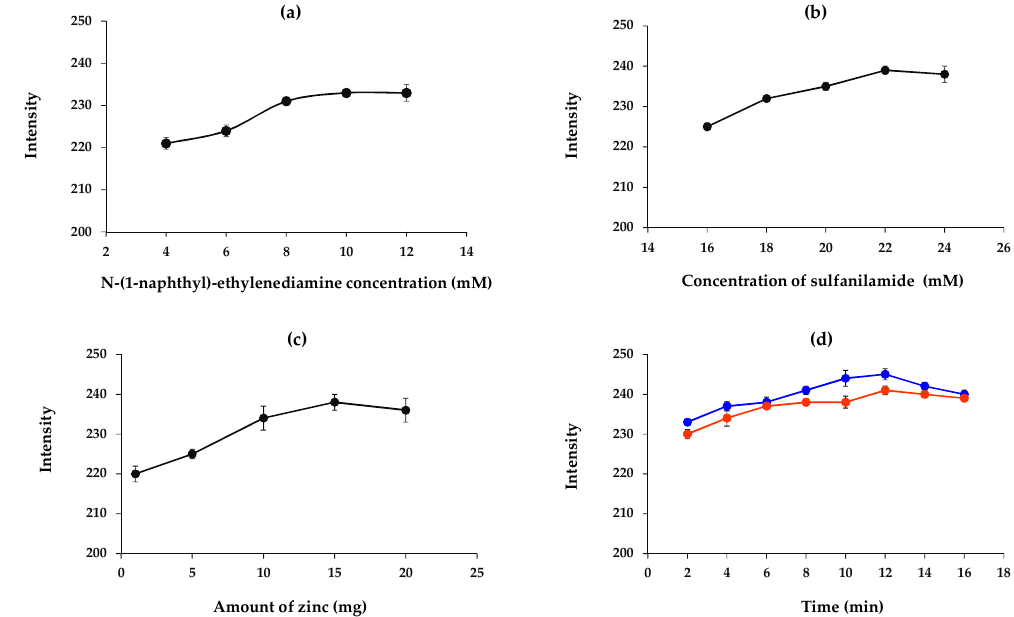
Figure 6. E ff ects of ( a ) N-(1-naphthyl)-ethylenediamine concentration and ( b ) sulfanilamide concentration on 10 mg L − 1 nitrite detection as well as of ( c ) amount of zinc for 50 mg L − 1 nitrate detection and ( d ) reaction time for 10 mg L − 1 nitrite (blue line) and 50 mg L − 1 nitrate (orange line) detections (n =